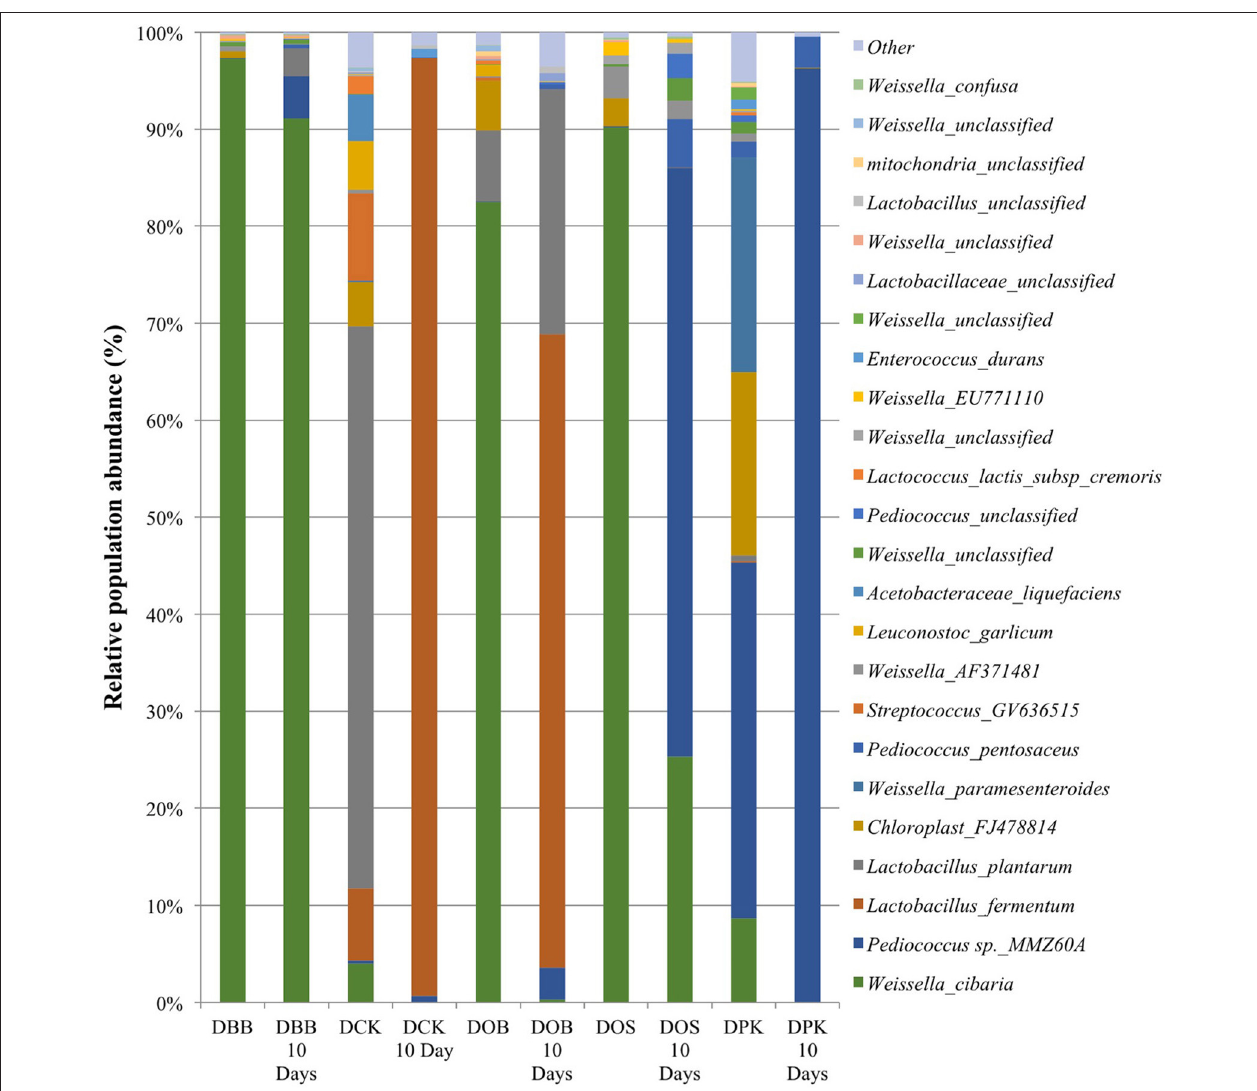
FIGURE 2 | Bacterial composition (OTUs at the species level based on 16S amplicon sequencing) of the five starters and the corresponding microbial communities after 10 days of fermentation (labeled “10 Days”). DBB, DCK, DOB, DOS, and DPK are the five traditional Cambodian